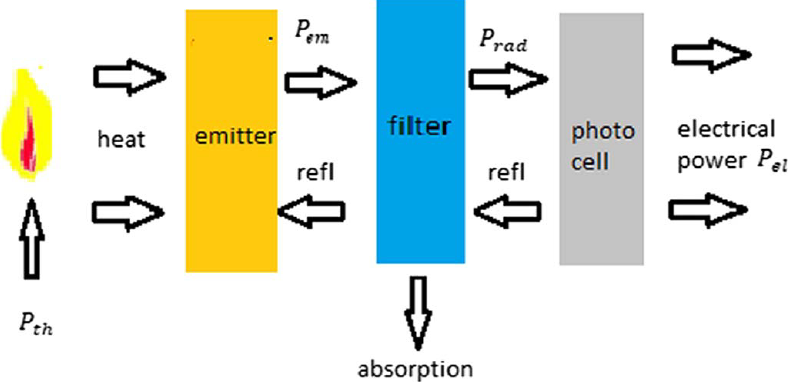
Figure 4. General structure of TPV system. Reproduced from [73], Oxford: 2020